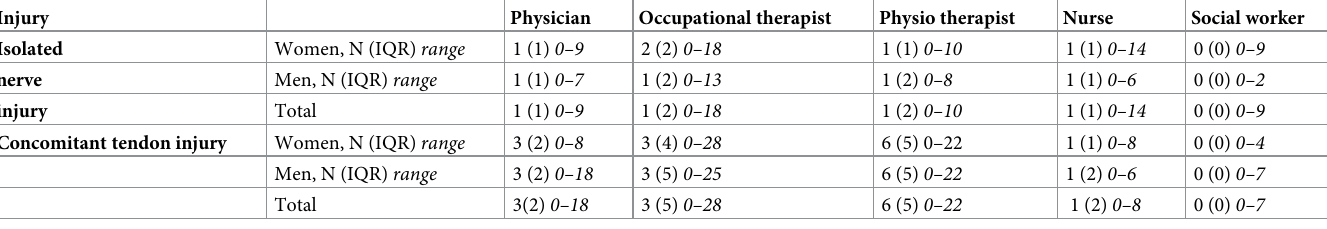
Table 4. Number of visits to health care personnel after surgical treatment for a digital nerve injury in Stockholm, Sweden, 2012–2018.